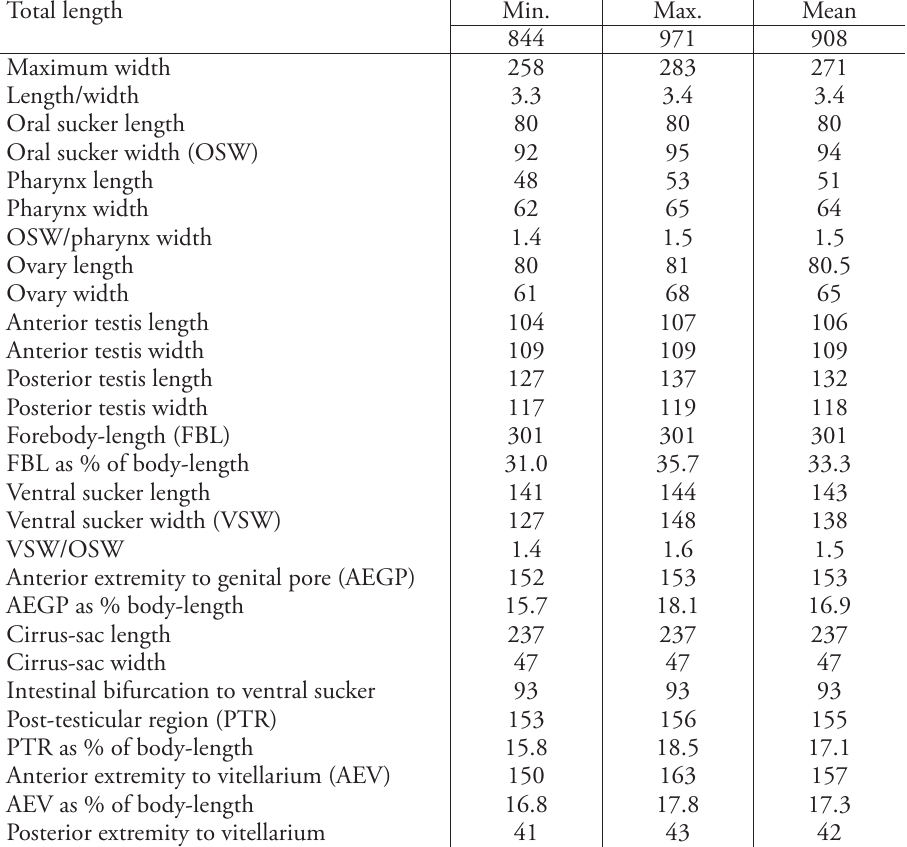
Table 4. Measurements (in μm) of Macvicaria kingscotensis n. sp. from Haletta subfasciatus (n=2). Total length Min.